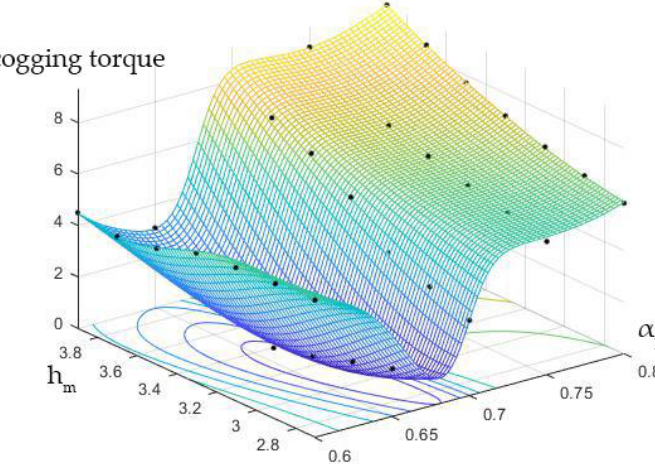
Figure 18. Model of influence of different auxiliary pole sizes on cogging torque.